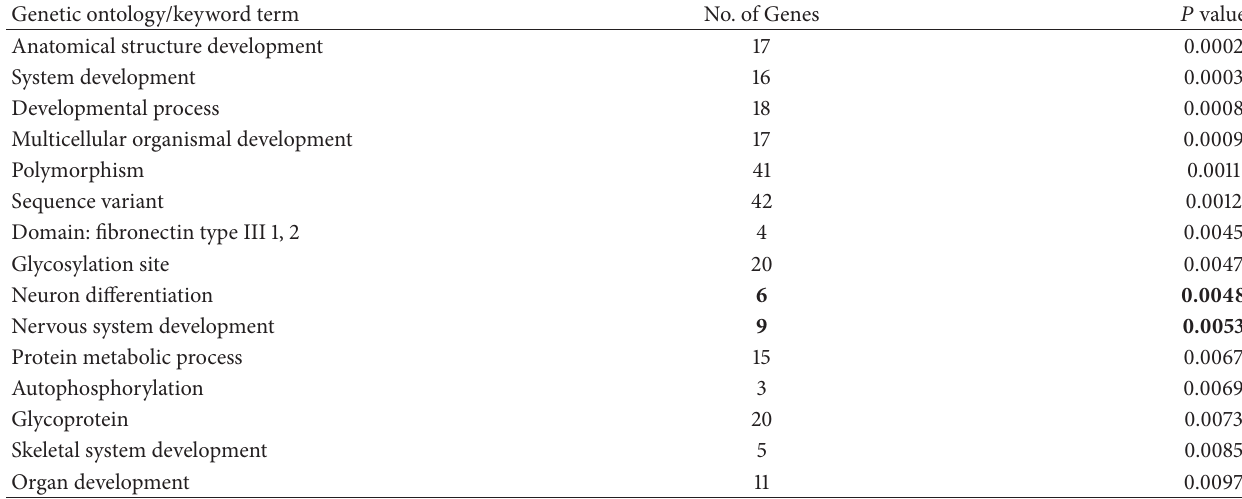
Table 3: Cluster analysis of genes having significantly different methylation patterns in women with